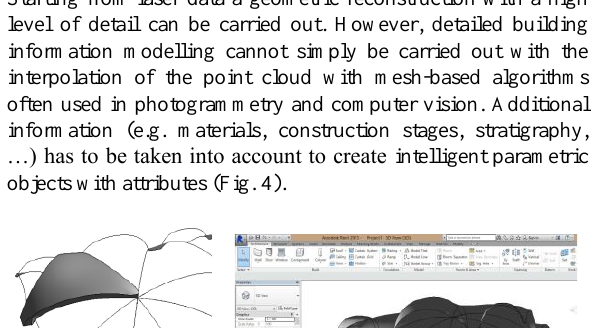
Fig. 5. The parametric BIM in Revit with the advanced representation of irregular objects (e.g. the selected wall features variable verticality